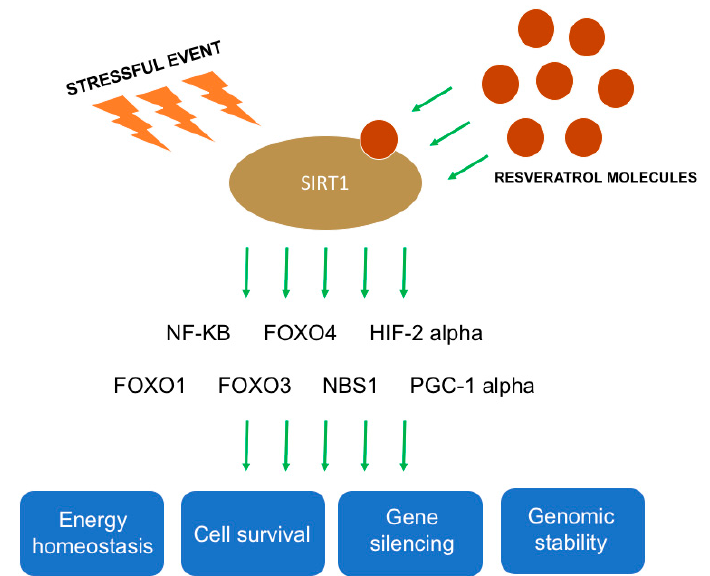
Figure 2. Mechanisms of action of resveratrol on silent information regulator 2 type 1 (SIRT1). Following a stressful event, resveratrol activates SIRT1 that binds di ff erent genes such as NF-kB, FOXO4, HIF 2 alpha, FOXO1, FOXO3, NBS1, and PGC-1 alpha. The activation of these genes is correlated with regulation of energy homeostasis, cell survival, gene silencing, and genomic